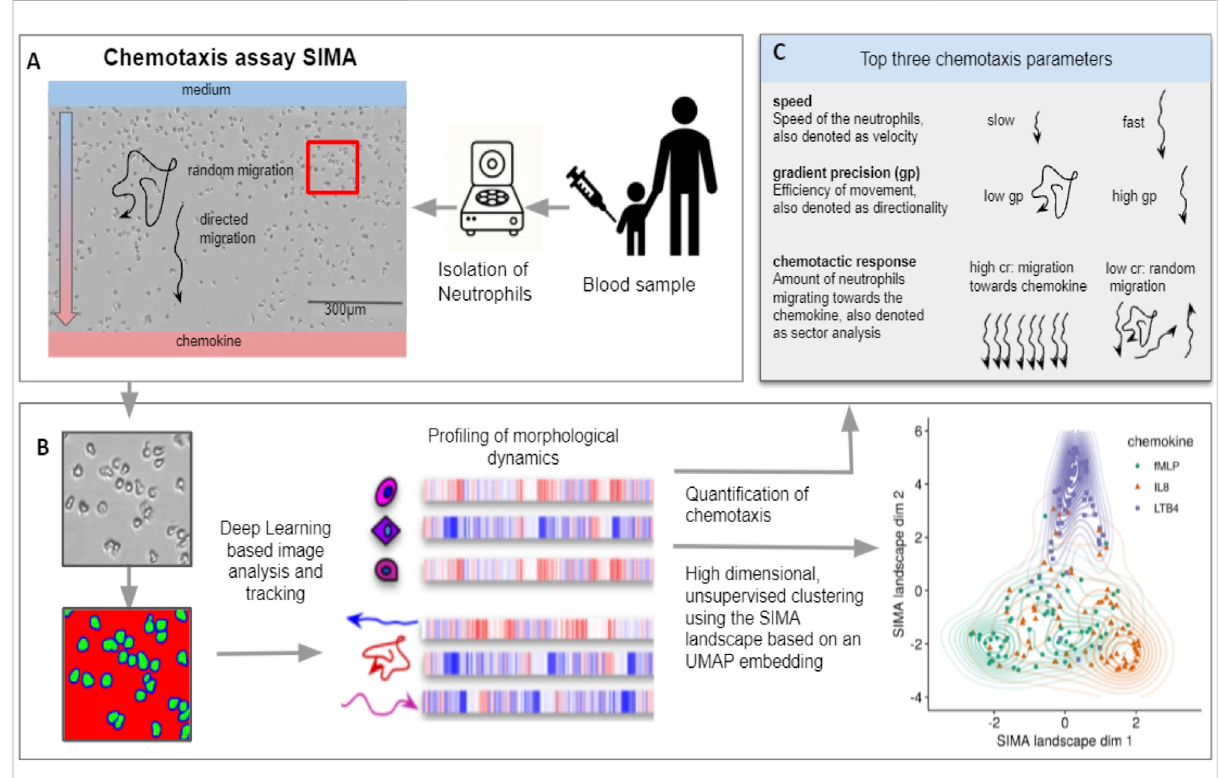
FIGURE 1 Pipeline of the SiMA chemotaxis analysis. (A) Neutrophils are isolated from a blood sample and chemotaxis is induced using a SiMA assay. For each patient, the migration towards IL8, fMLP and LTB 4 is recorded using time lapse microscopy. (B) A Deep Learning based image segmentation (UNet model) is used to identify and track neutrophil granulocytes. For each experiment, single-cell and single-trajectory pro fi les are created using CellPro fi ler and MigrationmineR, describing each neutrophil with a total of 25 features (after feature selection). These features are aggregated on an experiment level and used for quanti fi cation of chemotaxis. (C) The most telling and interpretable migration parameters are speed, chemotacticresponse and the gradient precision. A multidimensional analysis is performed using thecompletefeature set, which is projected into a two dimensional SiMA landscape using the UMAP algorithm for dimension